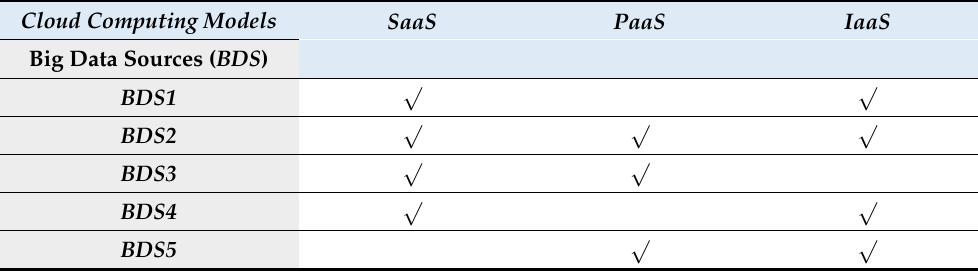
Table 3. Contributions of Cloud Computing models to Big Data sources.